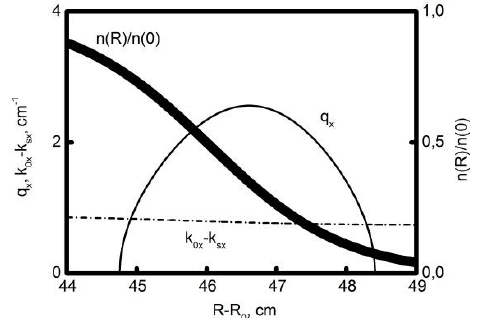
Fig. 1. Dispersion curves of the interacting waves. The thick solid curve shows the dimensionless density. The dashed dotted curve is the difference between the numbers of the pump and scattered O-mode waves k k  . The solid curve 0 x sx q q q q   , 1 2.4 cm is the EP wave number ( , 0) q   . The x x ym z ym pump and scattered wave frequencies are 140 GHz, f  0 137.02 GHz f  ; the scattering angle is 0 5.3  ; 2 cm   . s ETB